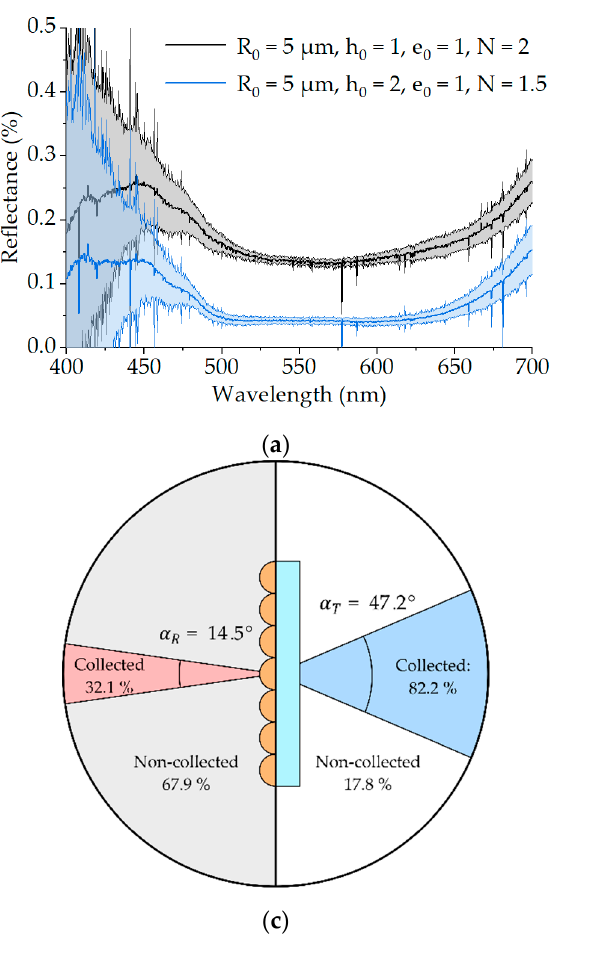
Figure 3. Structure’s reflectance and transmittance characteristics as a function of the design parameter from Equation (1). ( a ) Reflectance spectra of the most and least reflective structures with error and corresponding shape parameters; ( b , d ) average reflectance (at λ = 550 nm) and transmittance of structures printed with corresponding error: ( b ) Hemispheres with varying radius R 0 ( h 0 = 1, e 0 = 1 and N = 2), ( d ) structures with varying height factor, h 0 , elongation factor, e 0 , pyramidal factor, N , and combinations of these parameters; ( c ) Collection angles and percentage of collected and transmitted light intensity estimation based on calculation in Section S5 (for a hemisphere with R 0 = 5 µ m and at λ = 550 nm). All errors in ( a , b , d ) correspond to 1 σ